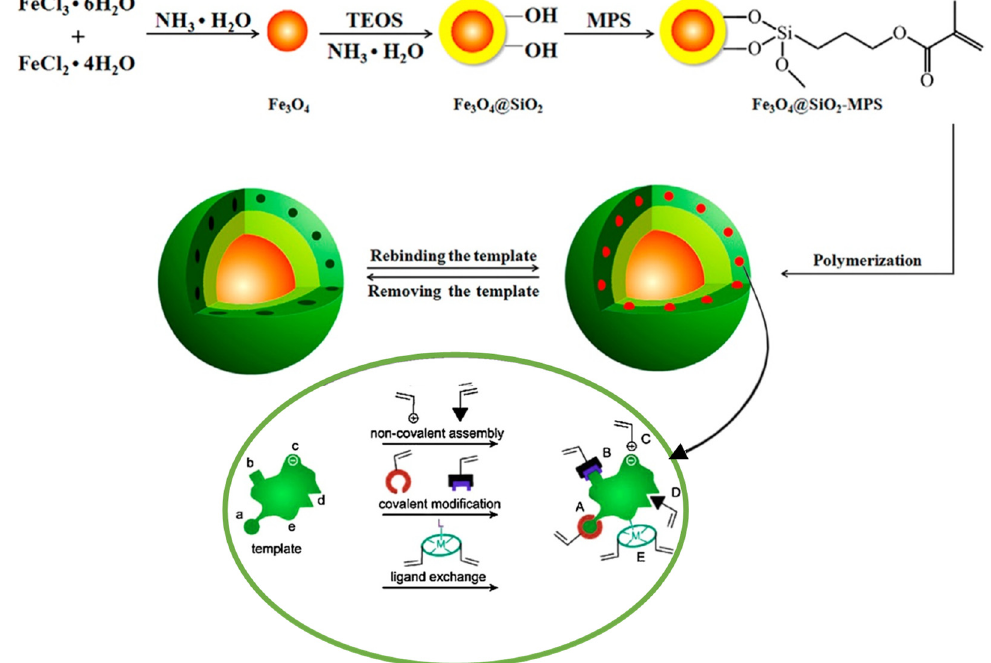
Figure 3. Schematic description of the synthesis and preparation of a magnetic MIP. The procedure goes through the obtention of iron (II, II) oxide (magnetite) from the co-precipitation of FeCl·H 2 O and FeCl 3 ·6H 2 O in NaOH solution or ammonia. Then the magnetite surface is modified by silanization using TEOS (tetraethyl orthosilicate) and functionalized using MPS or other silanes with multiple bonds for further polymerization. The MIP is then prepared using different crosslinkers and monomers. The last stage consists of removing the template molecules after polymerization. Adapted with permission from [54]. Copyright © Elsevier 2017.